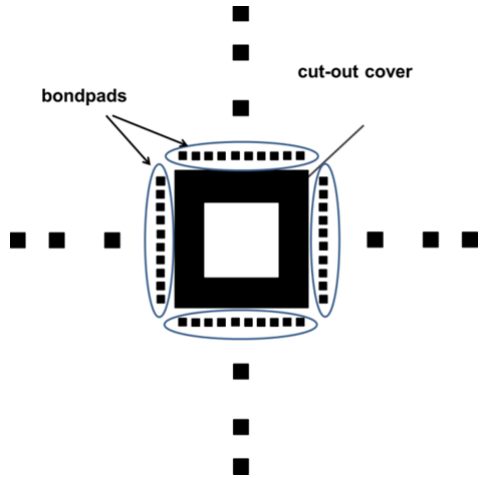
Figure 5. Geometric pattern used in the metallic